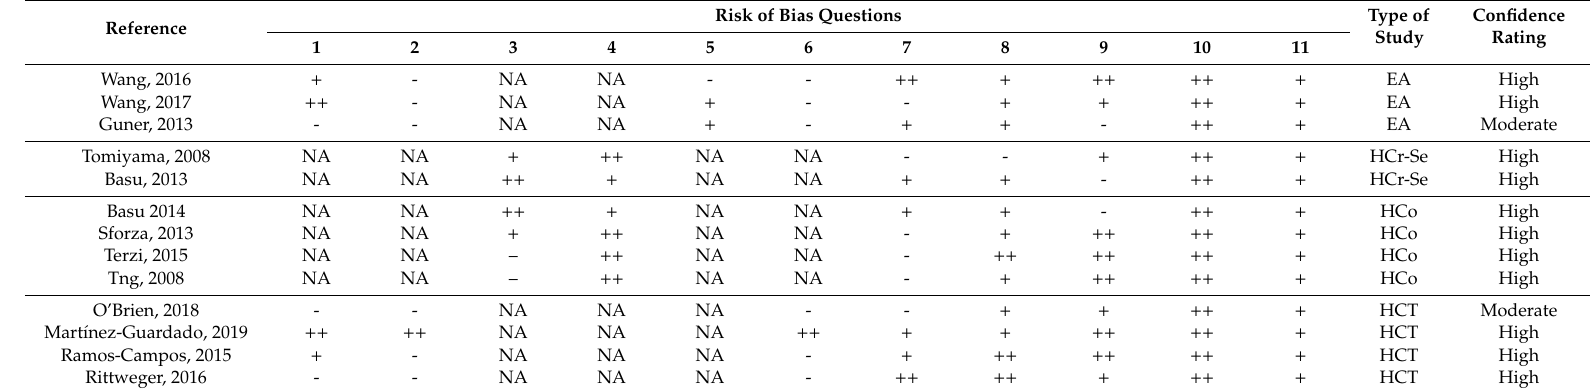
Table A2. Risk of bias and confidence rating ratings for in vivo studies.